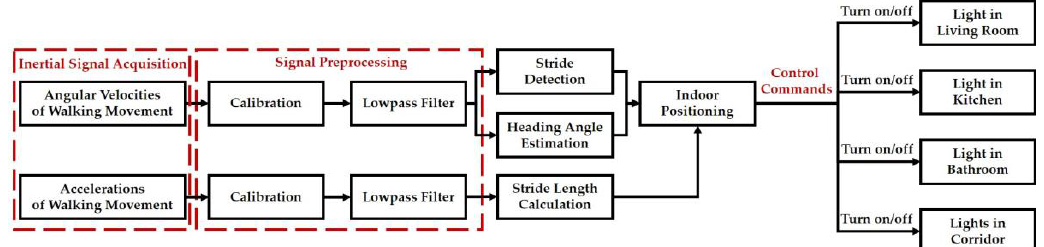
Figure 12. Block diagram of the indoor positioning algorithm.